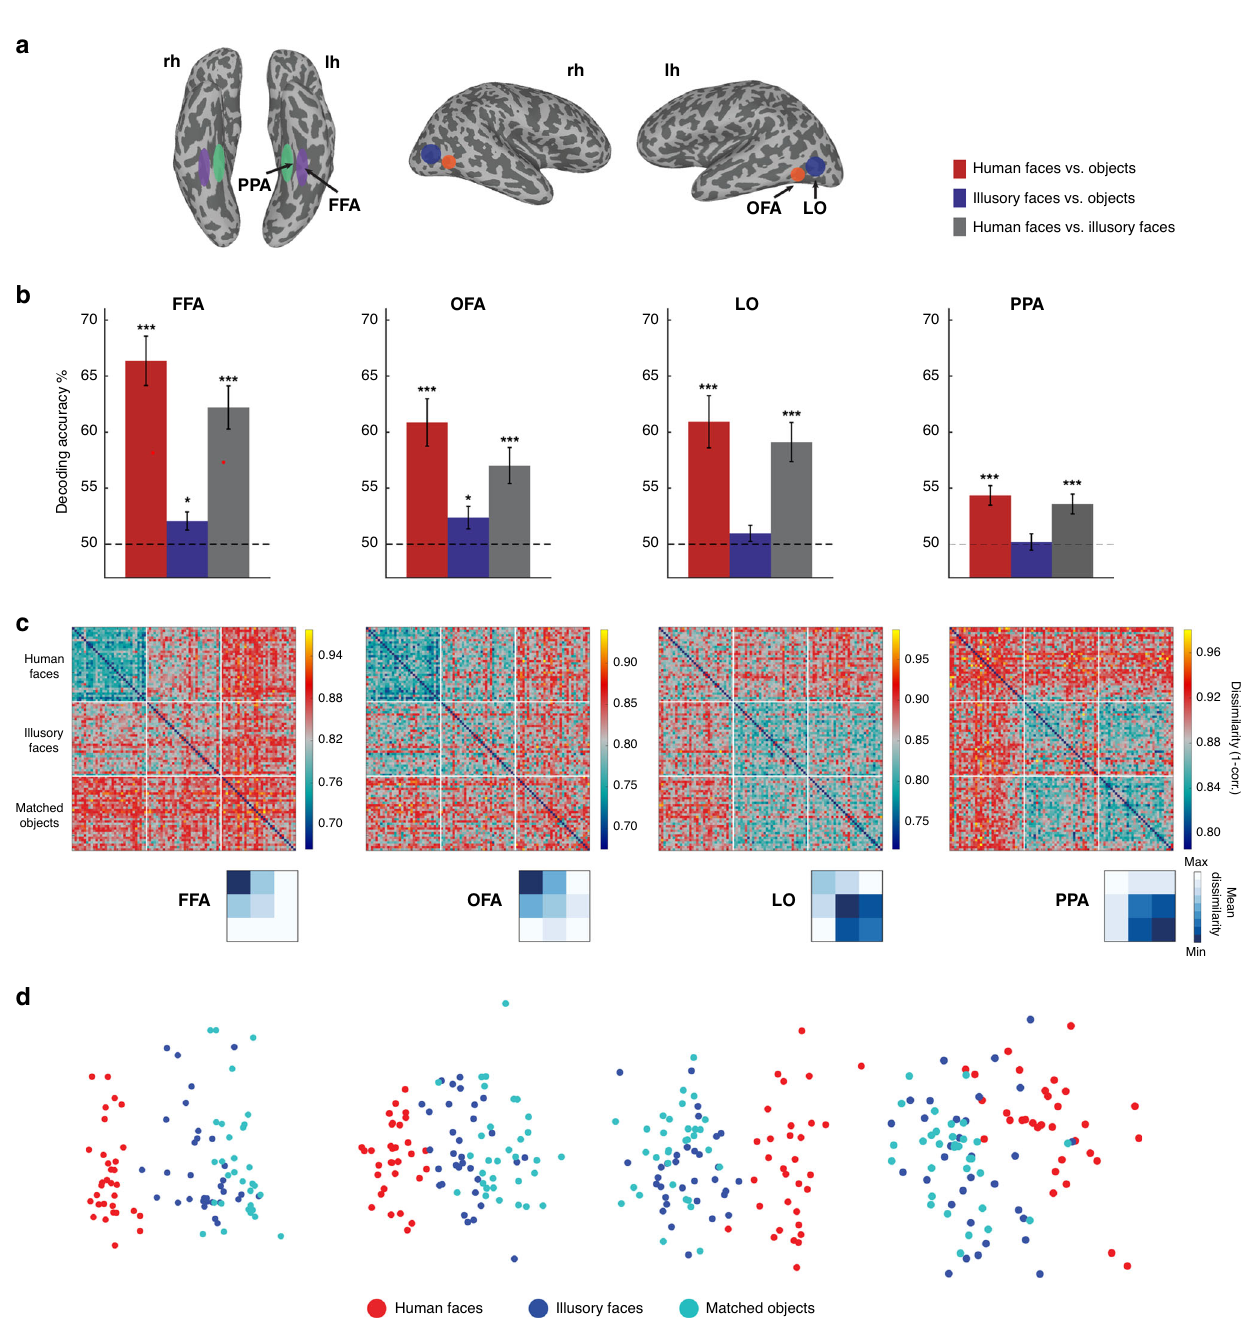
Fig. 2 fMRI results showing sensitivity to illusory faces in face-selective cortex. a Schematic visualization of the four functional regions of interest; each region was de fi ned individually in each hemisphere of each subject from their functional localizer. b Results of cross-decoding (train and test the classi fi er on brain activity associated with different exemplars so generalization across stimuli is required) the three stimulus categories from four regions of interest. The mean decoding accuracy is shown, averaged over N = 16 participants. Asterisks indicate conditions with statistically signi fi cant decoding, evaluated using one-sample t -tests (one-tailed) and FDR adjusted * p values < 0.05, and *** p values < 0.001 to correct for multiple comparisons. The distinction between human faces and objects with (FFA: p = 0.00004, OFA: p = 0.0005, LO: p = 0.0002, PPA: p = 0.0008) or without an illusory face (FFA: p = 0.00001, OFA: p = 0.0002, LO: p = 0.0003, PPA: p = 0.0002) can be decoded from activation patterns in all regions. Illusory faces can be discriminated from similar matched objects from activity in FFA ( p = 0.015) and OFA ( p = 0.020) only, but not in LO ( p = 0.11) and PPA ( p = 0.40). Error bars are SEM. Source data are provided as a Source data fi le . c Representational dissimilarly matrices (96 × 96) for all stimuli for the four regions of interest. The dissimilarity is calculated by taking 1-correlation (Spearman) between the BOLD activation patterns for each pair of stimuli. The colorbar range is scaled to the max and min of the dissimilarity values for each ROI for visualization. White lines indicate stimulus category boundaries. Insets show 3 × 3 matrices for each ROI averaged by category, excluding the diagonal. Source data are provided as a Source data fi le. d Visualization of the dissimilarity matrices in ( c ) using multidimensional scaling. The fi rst two dimensions following MDS are plotted, each of the points representing the 96 stimuli is colored according to its category membership. Proximity of the points represents more similar brain activation patterns for the stimuli. Note that in the FFA and OFA, the illusory faces are more separated from the matched objects and closer to the human faces compared to LO and